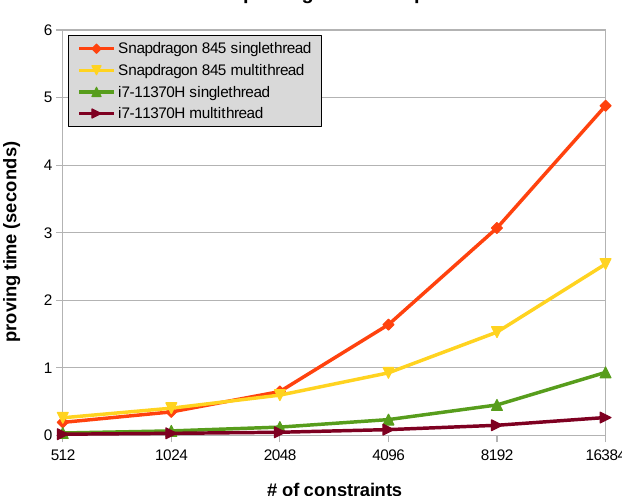
Figure 4. CPUs proving times comparison of ZPiE using different constraint amounts, single-thread and multi-thread modes. The used zk-SNARK is Groth’16, and the elliptic curve